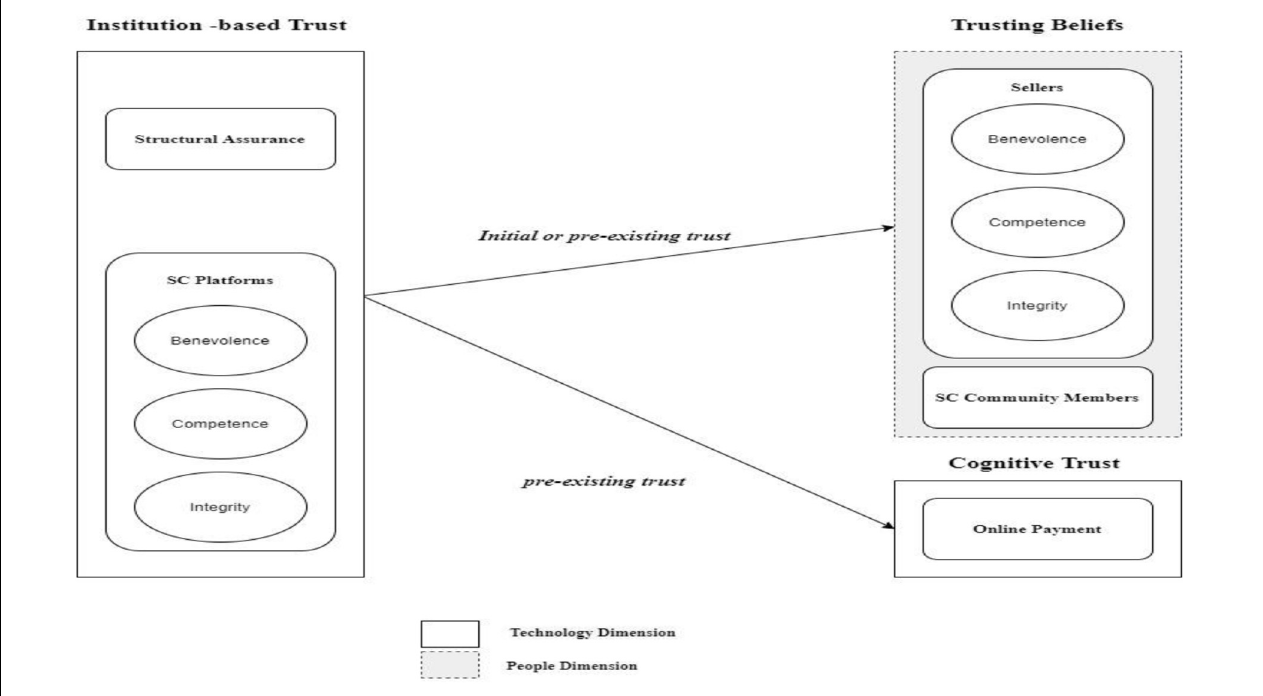
FIGURE 2 | Social commerce trust